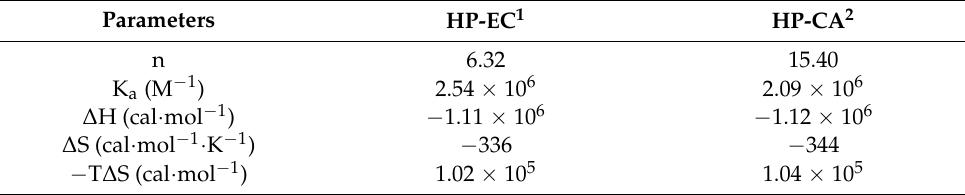
Figure 5. FT-IR spectrum of HP, EC and HP-EC mixture ( A ); CA and HP-CA mixture ( B ). HP: hawthorn pectin EC: epicatechin; CA: chlorogenic acid; HP-EC mixture: the mixture of hawthorn pectin and epicatechin; HP-CA mixture: the mixture of hawthorn pectin and chlorogenic acid. Table 1. Binding and thermodynamic parameters for the interaction between the different polyphe- nols with